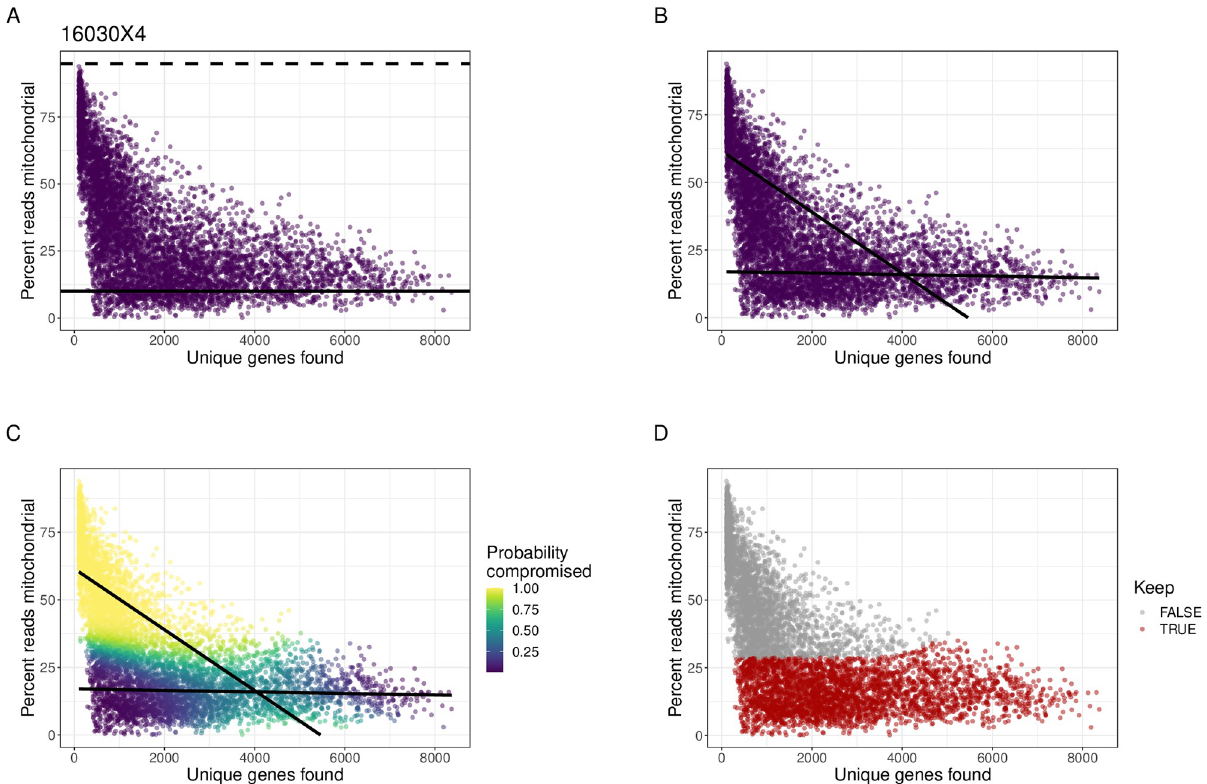
Fig 1. Uniform and data-driven quality control (QC) thresholds for scRNA-seq data. Cells ( N = 6618) from one high-grade serous ovarian cancer (HGSOC) tissue sample (Sample ID: 16030X4) with the number of unique genes detected ( x -axis) and percent of cell counts mapping to mitochondrial (mtDNA) genes ( y -axis). (A) Illustration of removing cells with a uniform QC threshold of greater than 10% cell counts mapping to mtDNA genes (solid black line) and a more data-driven threshold of greater than 3 median absolute deviations (MADs) of the percent of counts mapping to mtDNA genes (dotted black line). (B) Using our data-driven approach (miQC), we fit a finite mixture of standard linear regression models with two lines (black lines) to calculate a posterior probability of being a compromised cell. (C) Cells shaded by their posterior probability of being compromised. (D) Discarding all cells with � 75% probability of being compromised creates a data-driven QC threshold for scRNA-seq data.